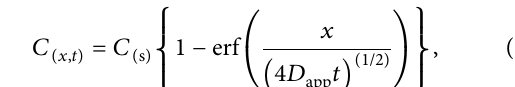
Figure 2: SEM sample